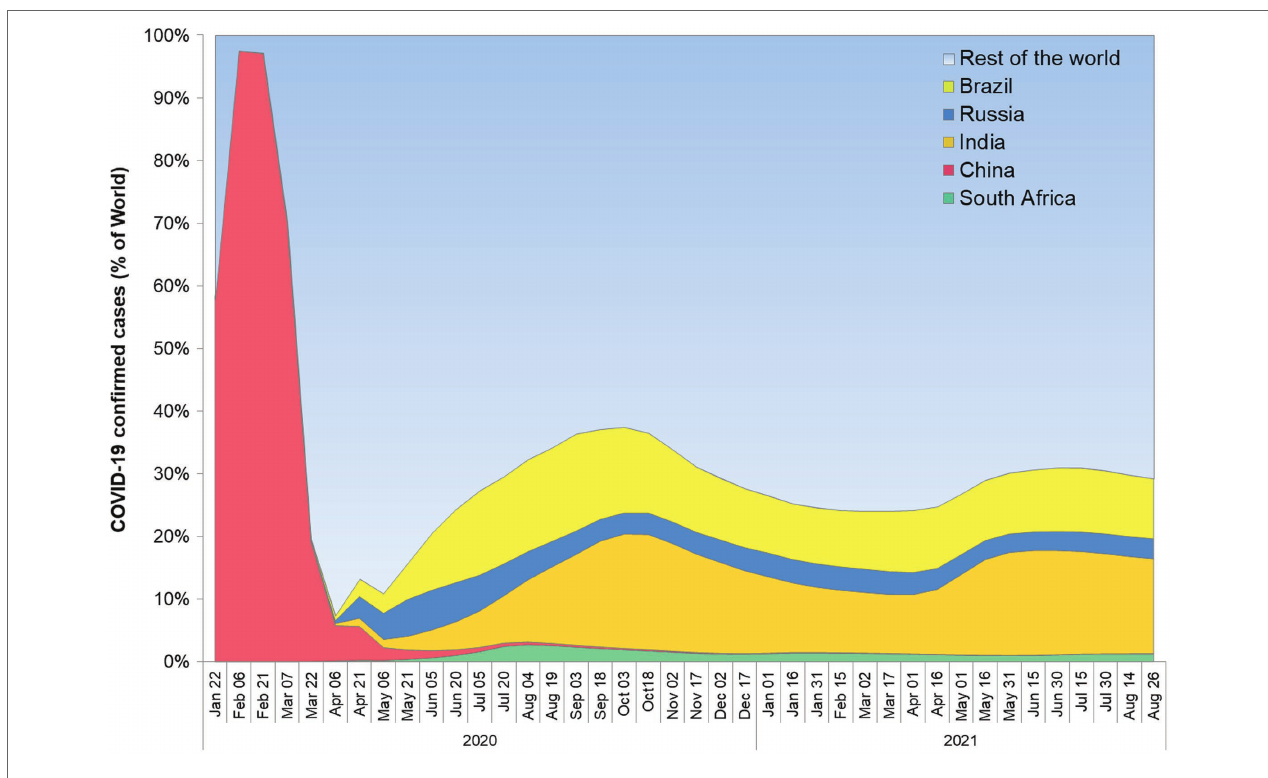
FIGURE 1 | BRICS nations share in confirmed cases worldwide.